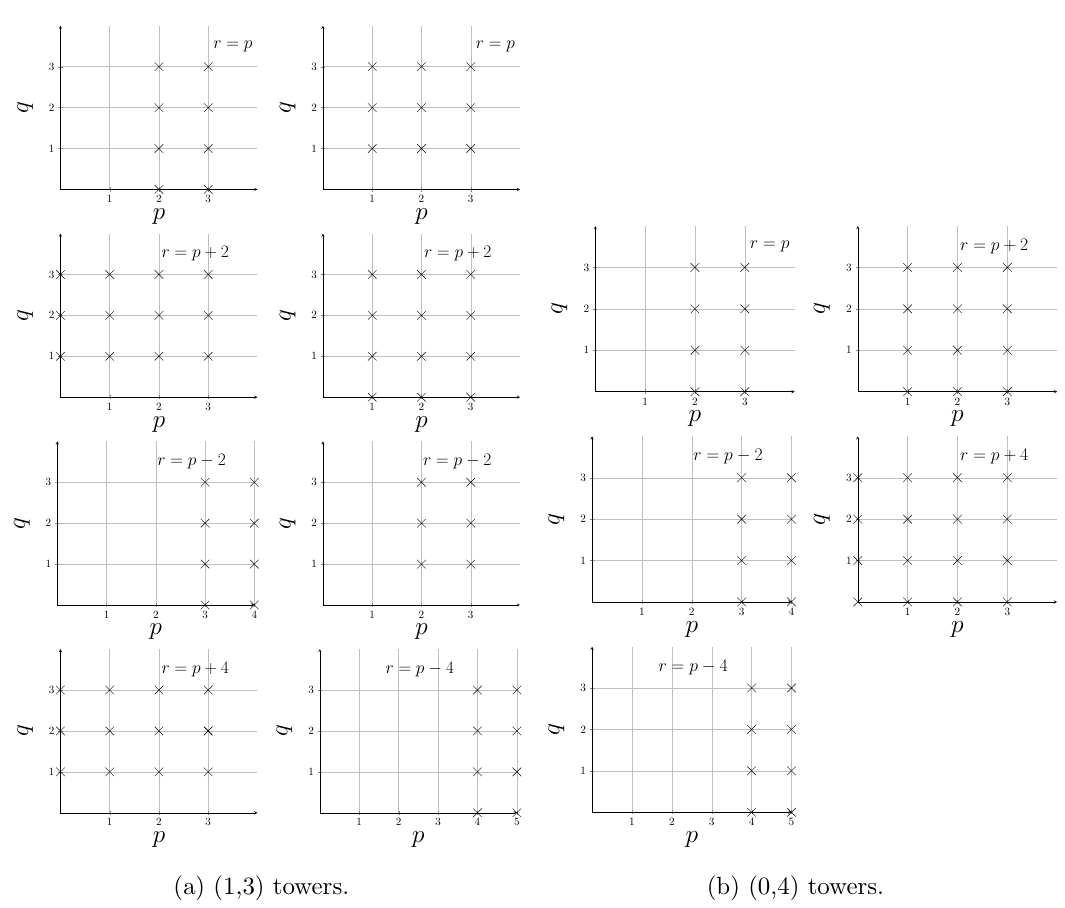
(a) (1,3) towers. (b) (0,4) towers. Figure 4. (1,3) and (0,4)